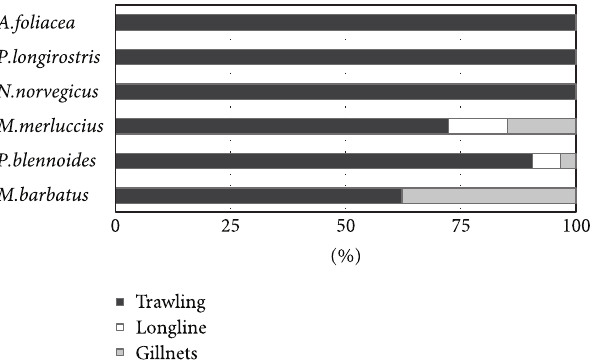
Figure 4: Percentage of commercial catches in some demersal species obtained with di ff erent gears in the north-western Ionian